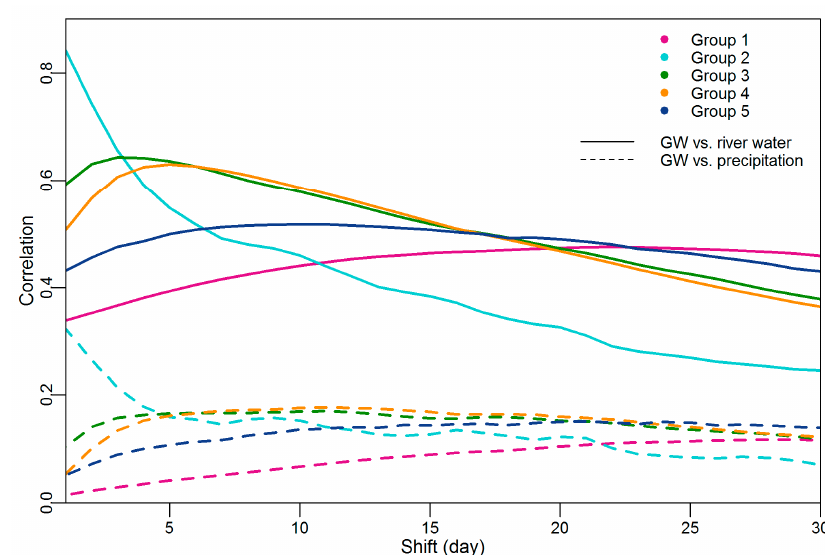
Figure 8. Cross-correlogram between the hydraulic heads and local precipitation levels (dash line)/Sava River discharge (full line) in different time lag data of the hydraulic head. Locations of groups are shown in Figure 2.